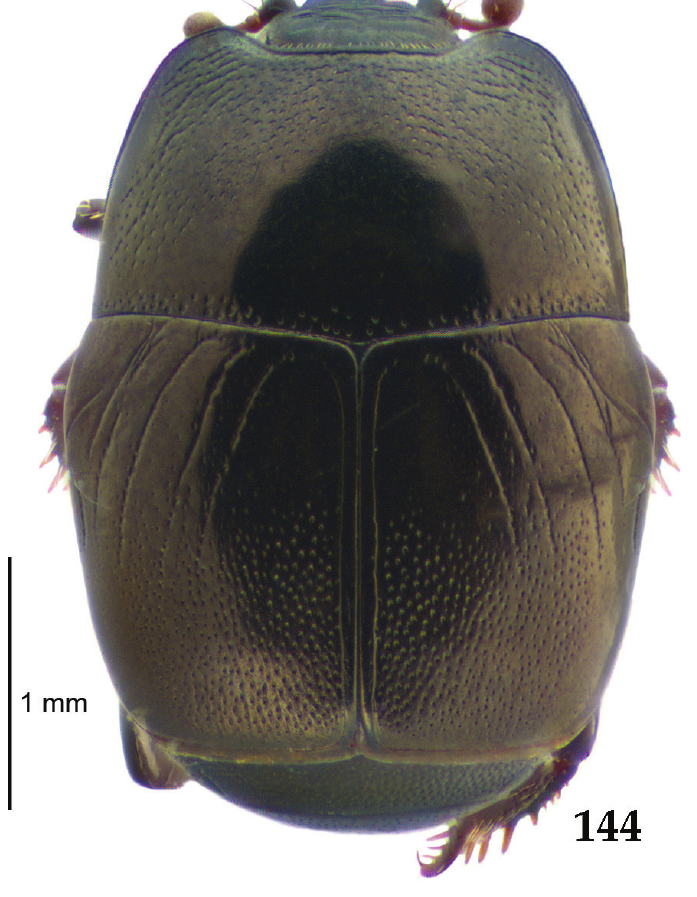
Figure 144. Hypocaccus ( Hypocaccus ) brasiliensis (Paykull, 1811) habitus, dorsal